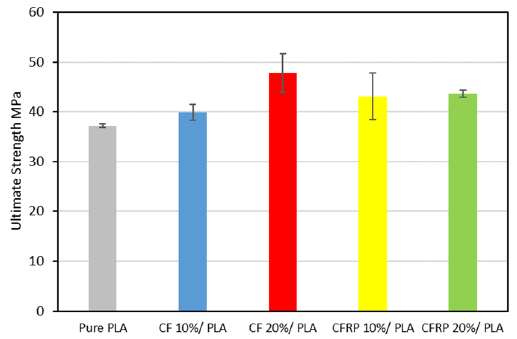
Figure 15. Ultimate Tensile Strength.